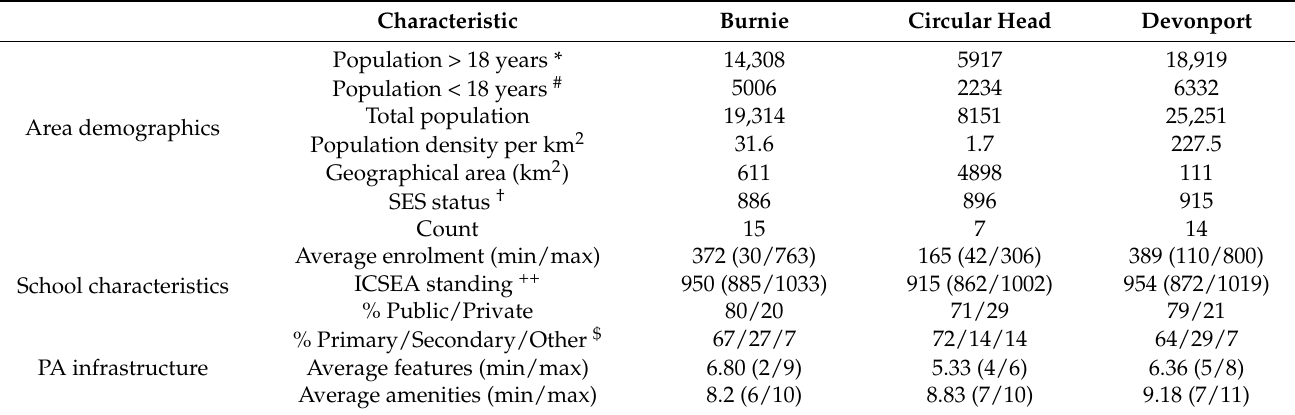
Table 1. Characteristics of the study areas and